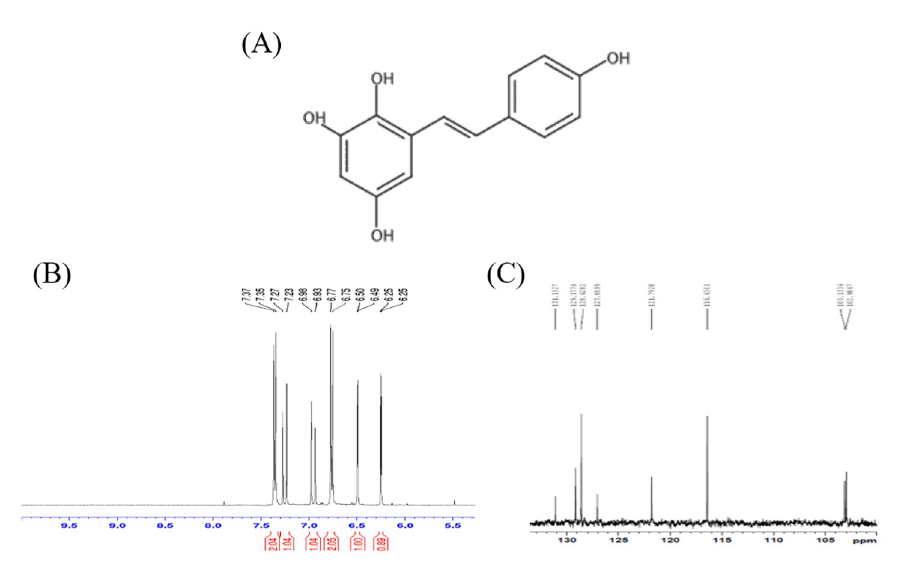
Fig 1. (A) Structure of TG1. (B) 1H NMR analysis of TG1. (C) 13C NMR analysis of